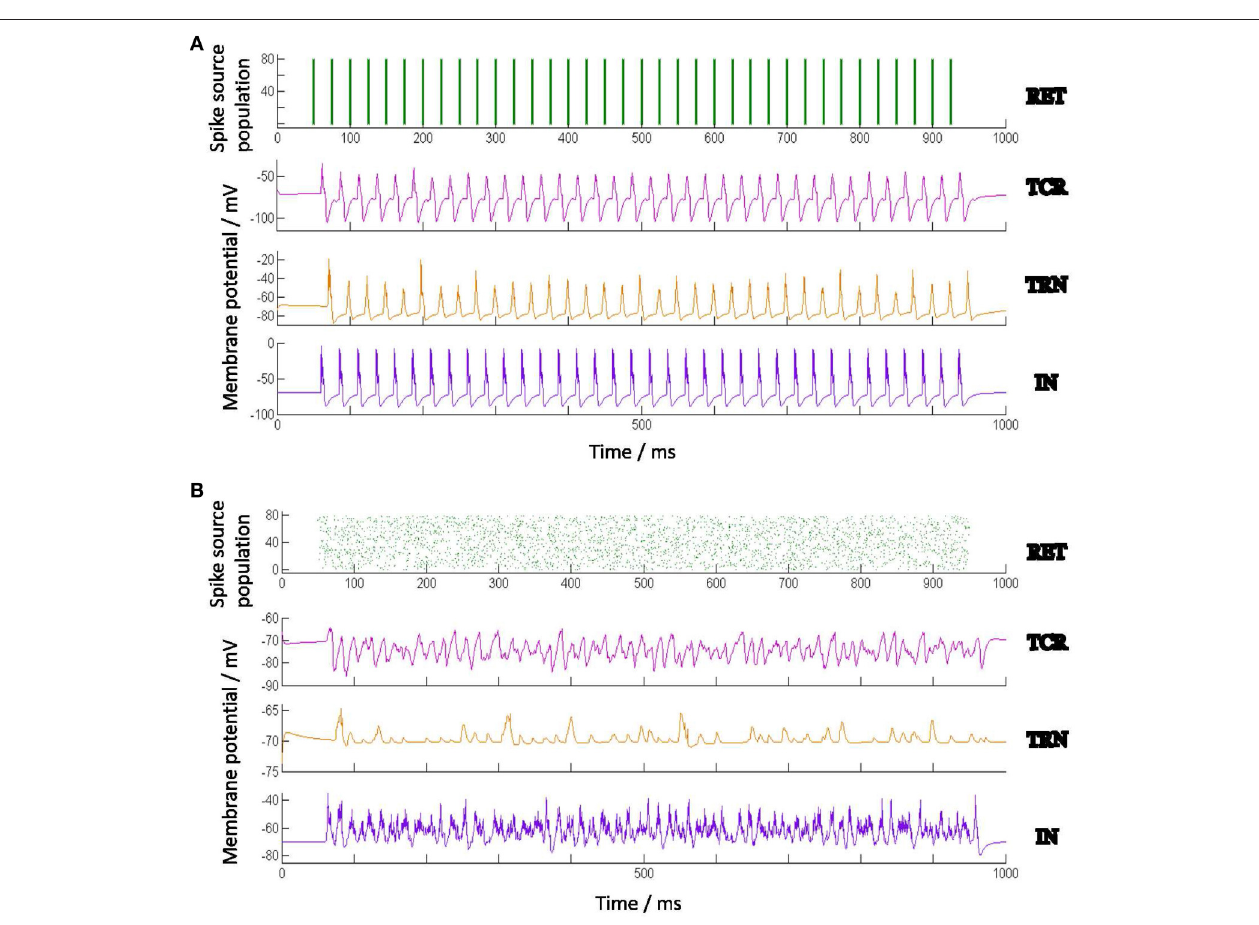
FIGURE 3 | Average population membrane potential with (A) periodic spike-train, and (B) Poisson spike-train input at 40 Hz. All neuronal and connectivity parameters are as in Tables 1 – 3 .